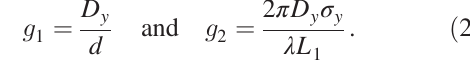
ffiffiffiffiffiffiffiffiffiffiffiffiffiffiffiffiffiffiffi p − 2 ln ð V Þ